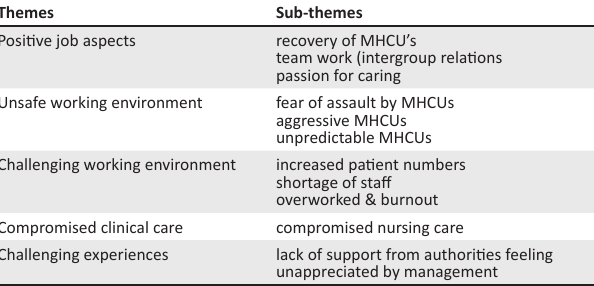
TABLE 1: Summary of themes that emerged during the